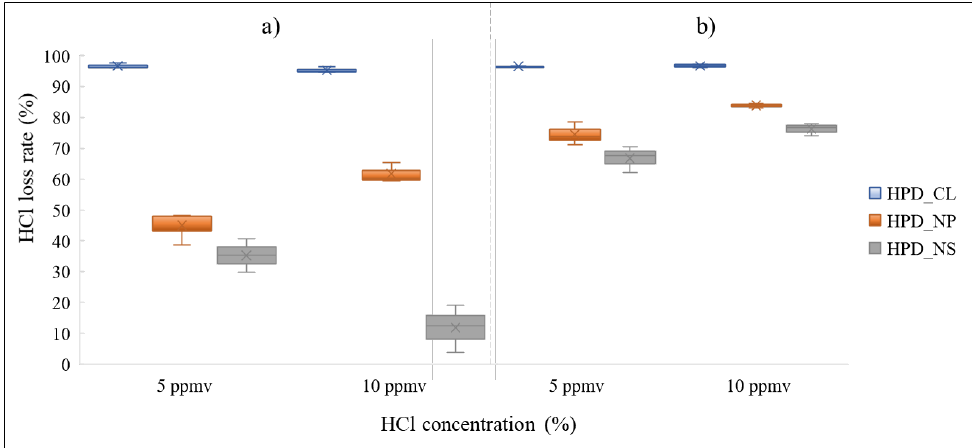
Figure 4. Loss rates of HCl caused by humidity pretreatment devices operated in room conditions with respect to various HCl concentrations at a ( a ) low humidity (4%) and ( b ) high humidity (17%).